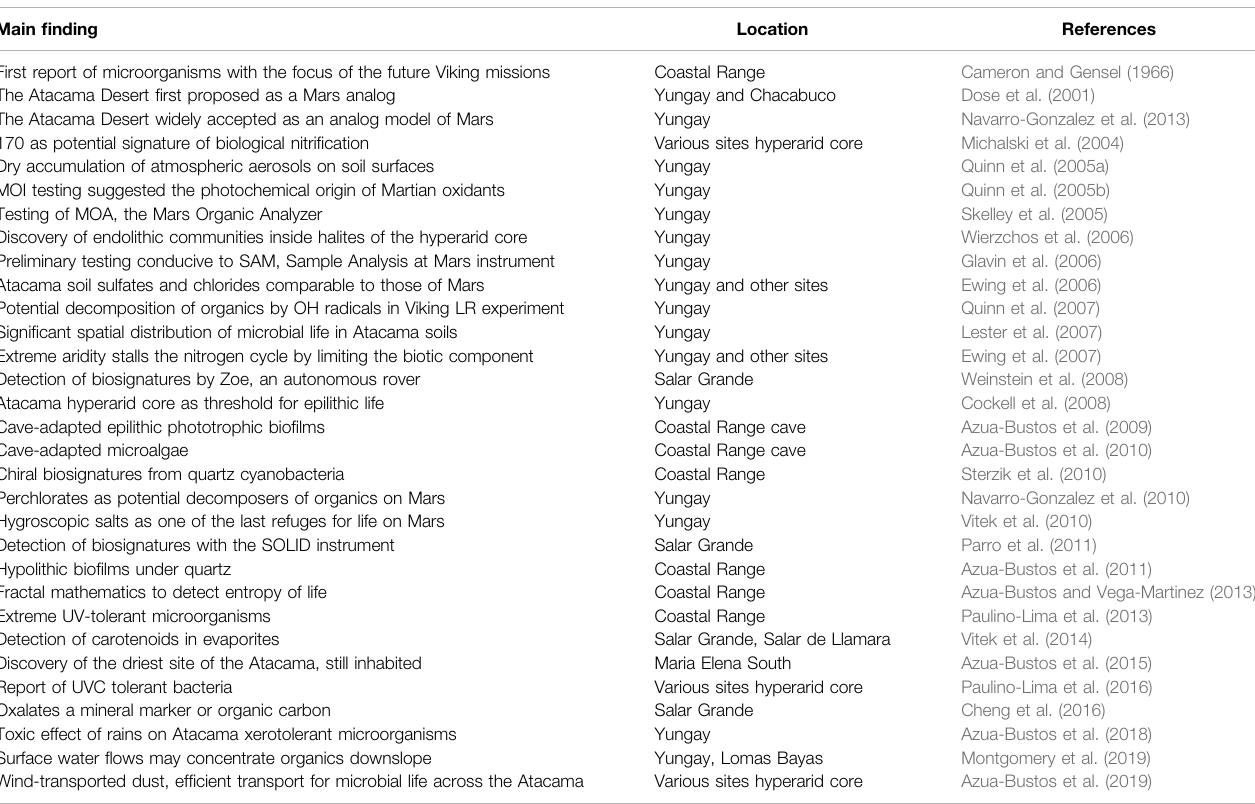
TABLE 1 | Selected main fi ndings covered in this review.